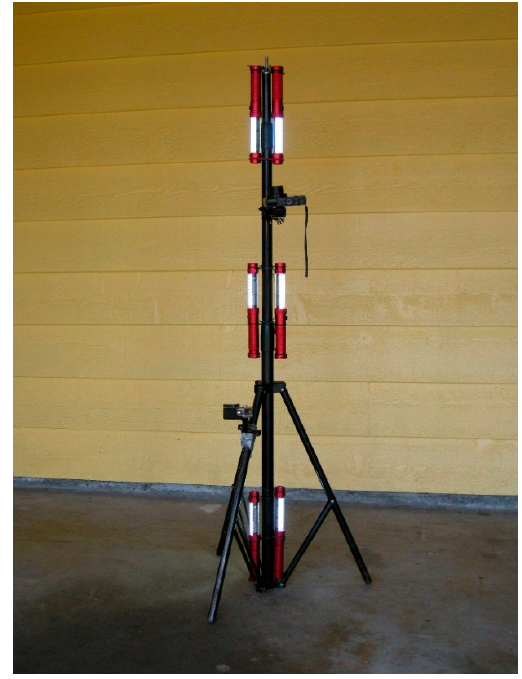
Figure 2. The photographic light stand and cameras used in the interior of the space. The cameras are clearly visible in the photo.